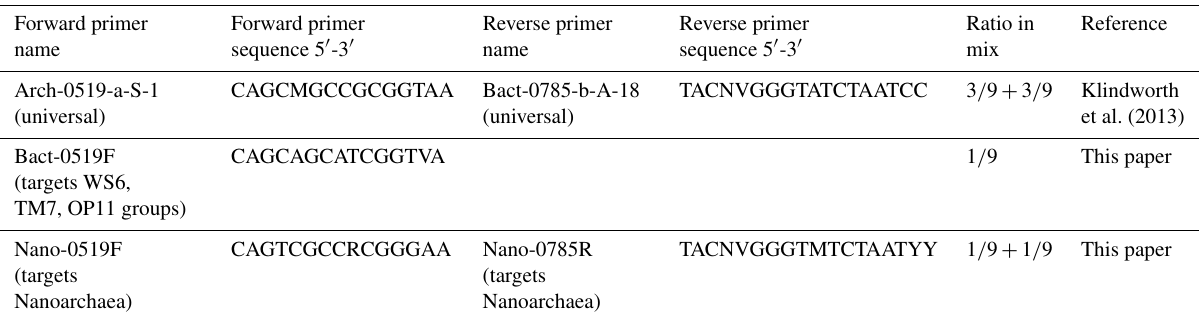
Table 2. Primers used for sequencing. Forward